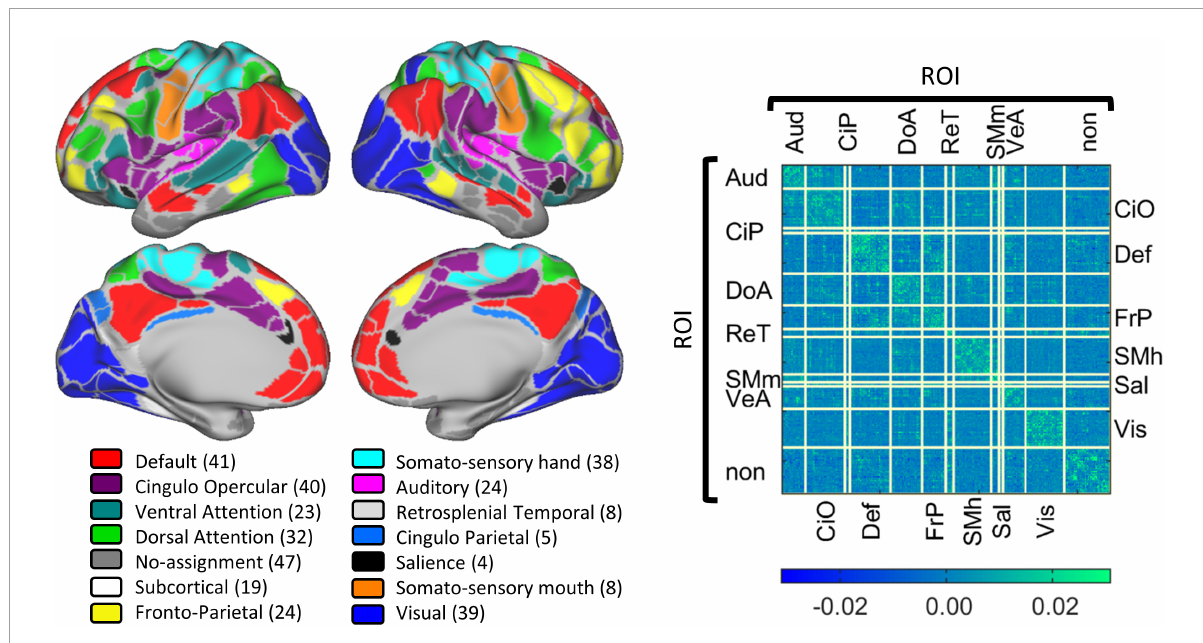
FIGURE2 Gordon parcelation schema. The (Left panel) displays a visual representation of the 13 defined cortical networks in the Gordon Parcelation. Networks are color coded with the number of regions of interest shown in parentheses. The (Right panel) shows the average connectivity matrix calculated as the average beta-weights of all the data included in this study. Each row and column correspond to a particular brain region, and each cell is a connection. Connections are grouped by functional network